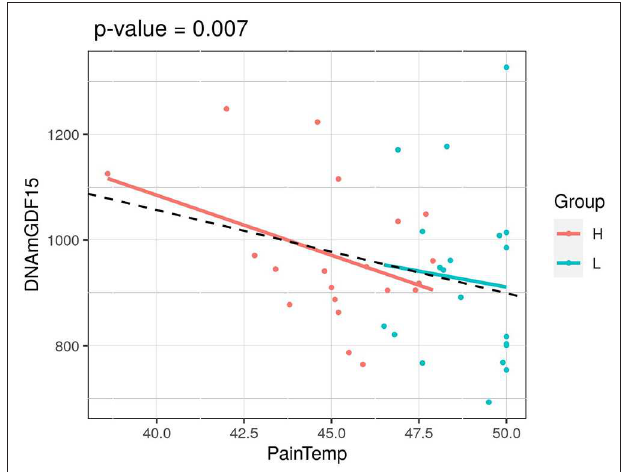
FIGURE 2 | Association of HPST value and DNAmGDF15 in HPS cohort (L, twins with lower heat pain sensitivity; H, with higher heat pain sensitivity). The p- value of a mixed linear model correcting for age and using family as a random effect is reported.